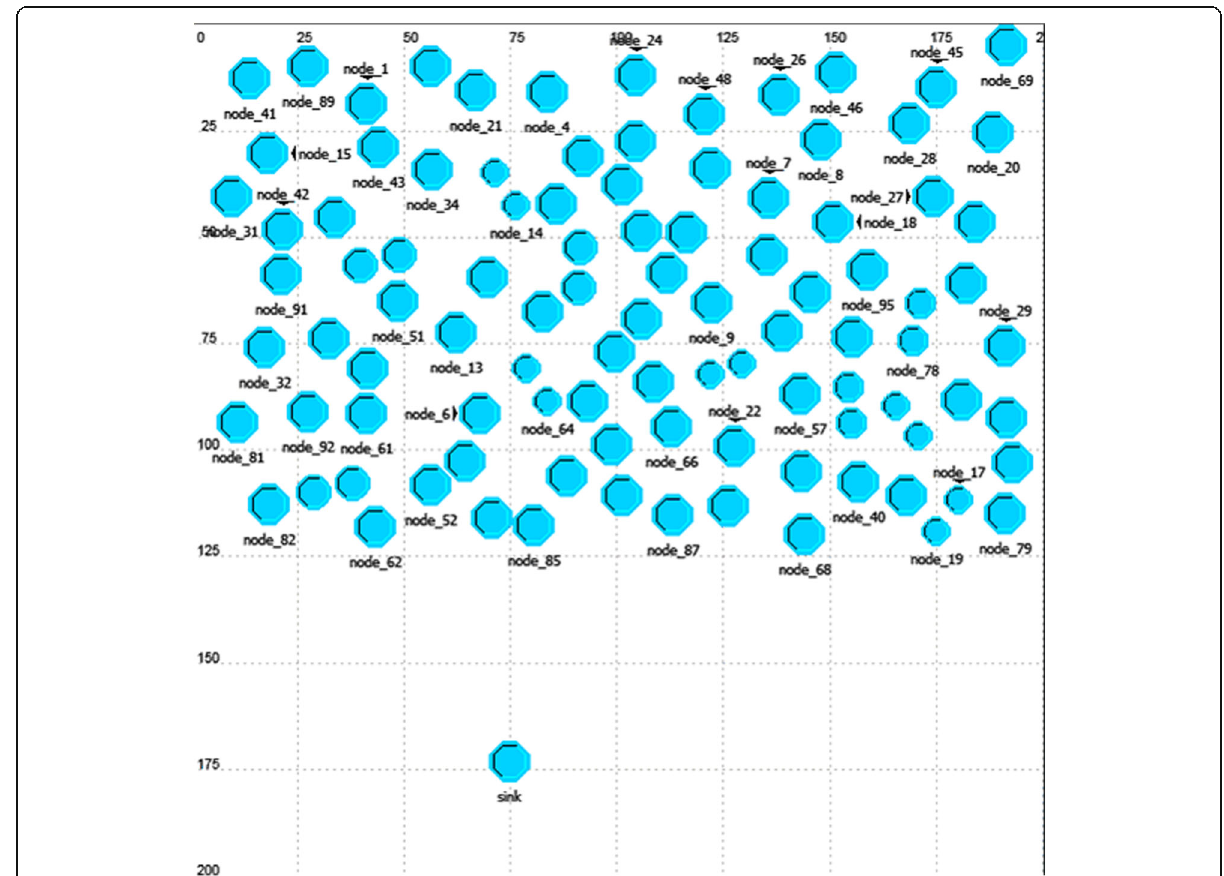
Fig. 7 The 100-node network model of the WSN. The 100-node network model of WSN is shown in this figure. One hundred nodes are randomly distributed between the area of ( x = 0, y = 0) and ( x = 200, y = 125) with the sink node at ( x = 75, y =